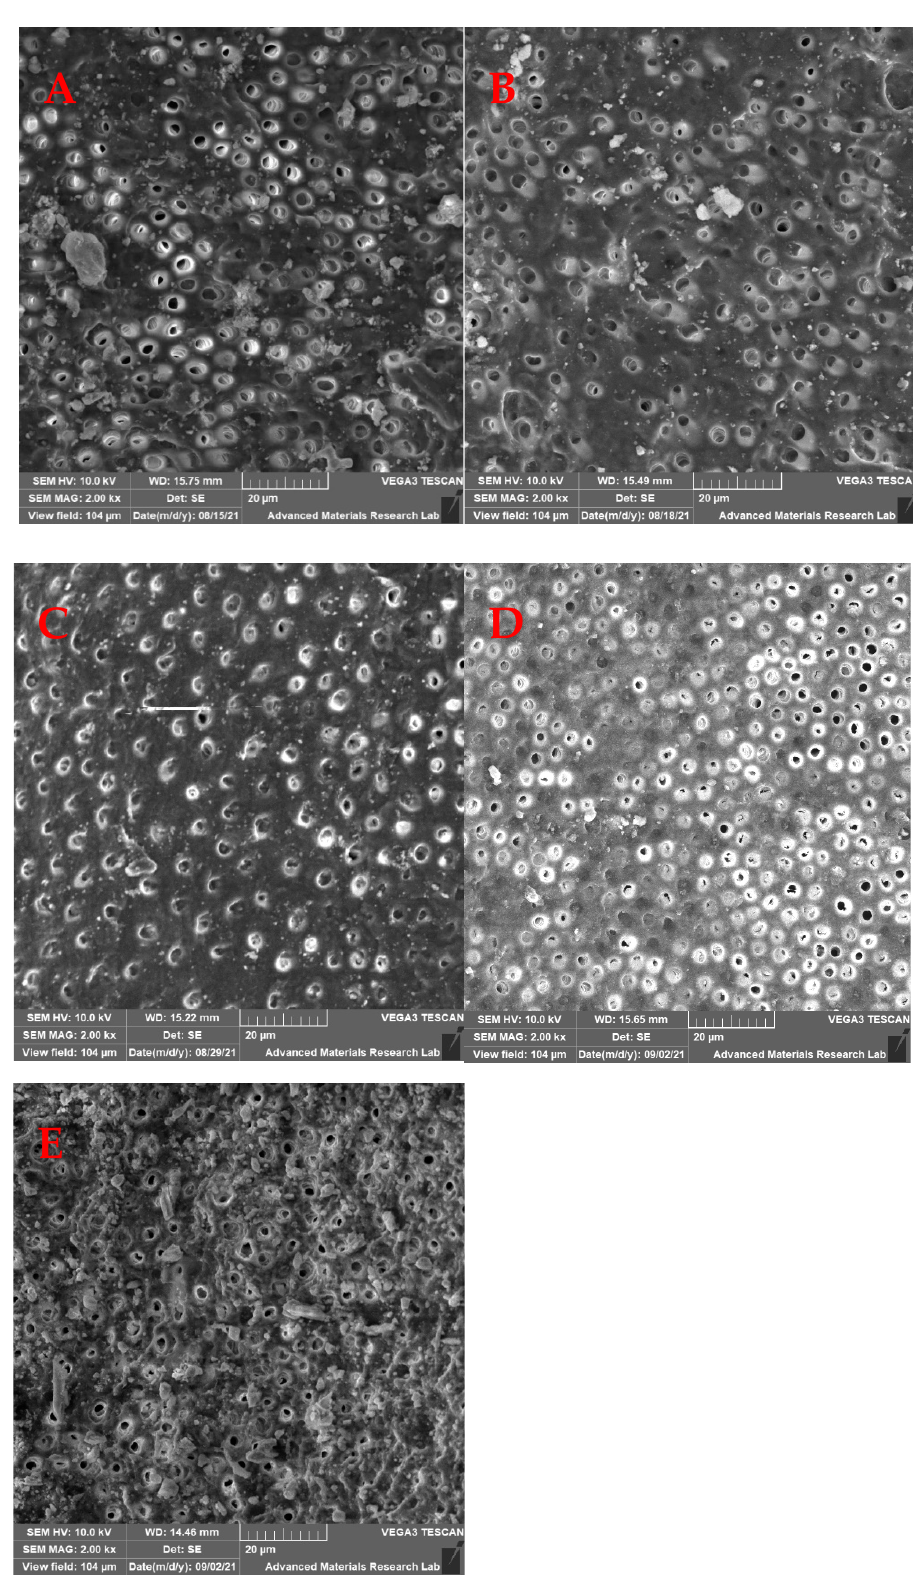
Figure 4. SEM photomicrograph (2000 × ) showing debris particles at the apical third. ( A ) Ultrasonic group, ( B ) Laser 1 group, ( C ) Laser 2 group, ( D ) Laser 3 group, and ( E ) Laser 4 group.